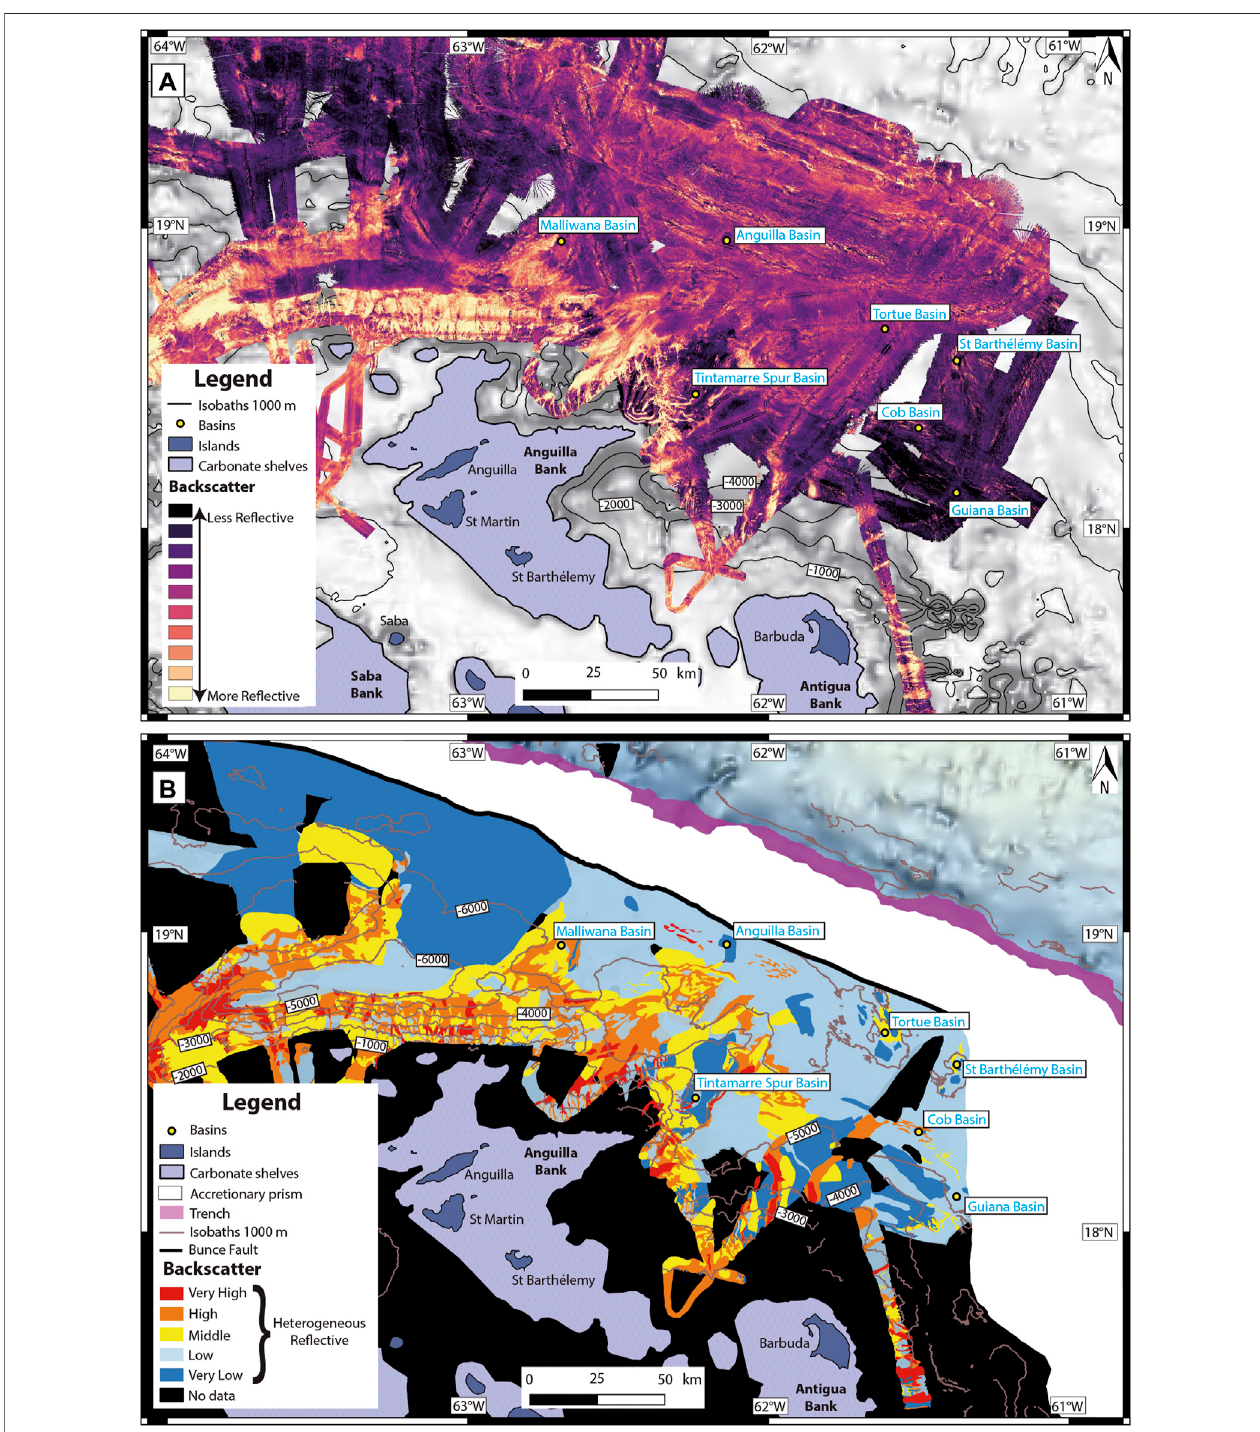
FIGURE 4 | Backscatter map: (A) Data (color scale plasma). (B) Interpretation. Five echo-facies: (a) Very High Heterogeneous Re fl ective (in red), (b) High HeterogeneousRe fl ective (inorange),(c)MiddleHeterogeneousRe fl ective(inyellow),(d)LowHeterogeneous Re fl ective(inblue),(e) VeryLowHeterogeneousRe fl ective (in dark blue). Please note thatgenerally, highly re fl ective echo-facies(a,b) are present especially in the canyon fl oor and areas cutby gullies, the medium re fl ective facies highlight some valleys, and less re fl ective facies (d,e) are present in spurs and deep basins.